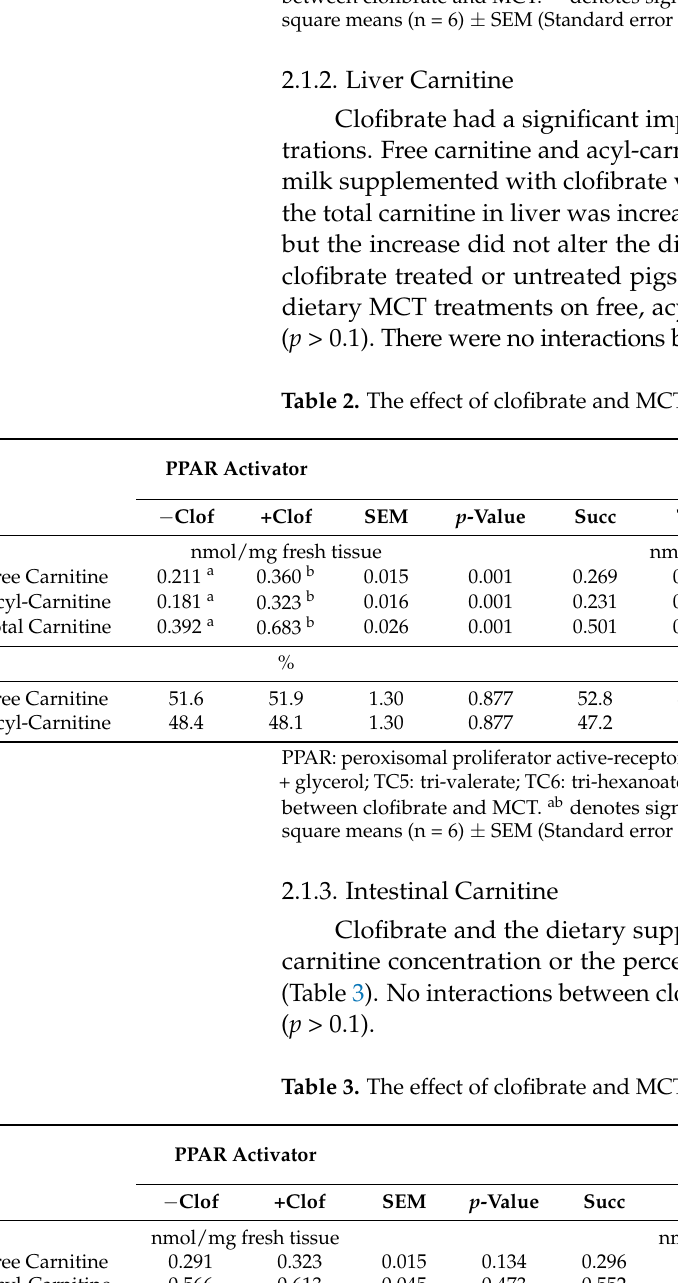
PPAR: peroxisomal proliferator active-receptor; MCT: medium chain triglycerides; Clof: clofibrate; Succ: Succinate + glycerol; TC5: tri-valerate; TC6: tri-hexanoate; TMPA: tri-2-methylpentonoate. The final column is the interaction between clofibrate and MCT. ab denotes significant ( p < 0.05) differences between groups. Values are the least square means (n = 6) ± SEM (Standard error means).